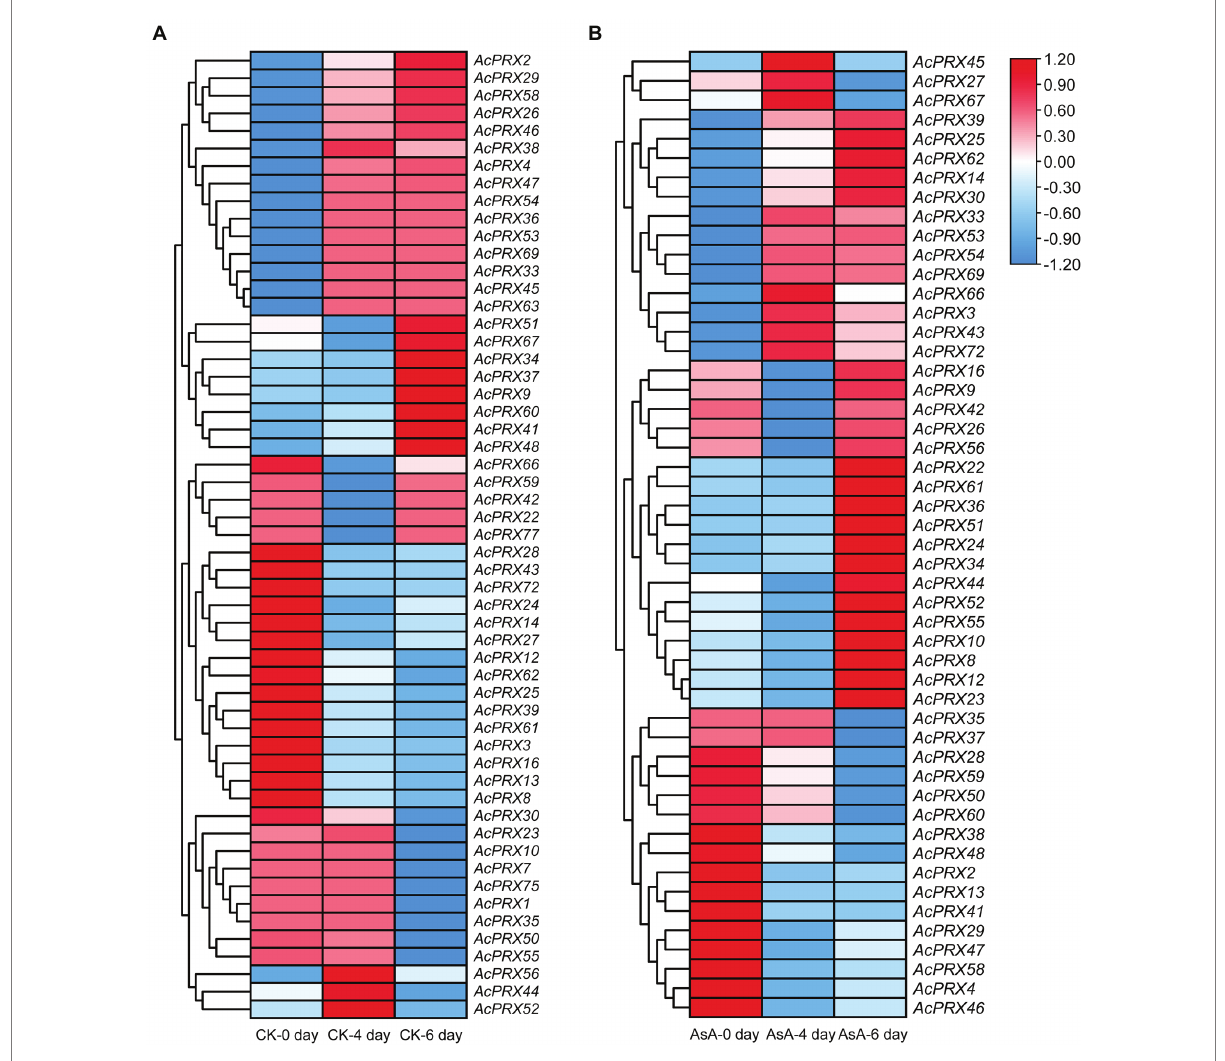
FIGURE 9 Expression patterns of AcPRXs in the control group (A) and after AsA treatment (B) . The transcript data were generated from three replicates. Log 2 fold change values were used to create the heatmaps. AcPRXs are clustered based on their phylogenetic relationships. Relative expression values are represented by colour, with red showing high expression and blue showing low